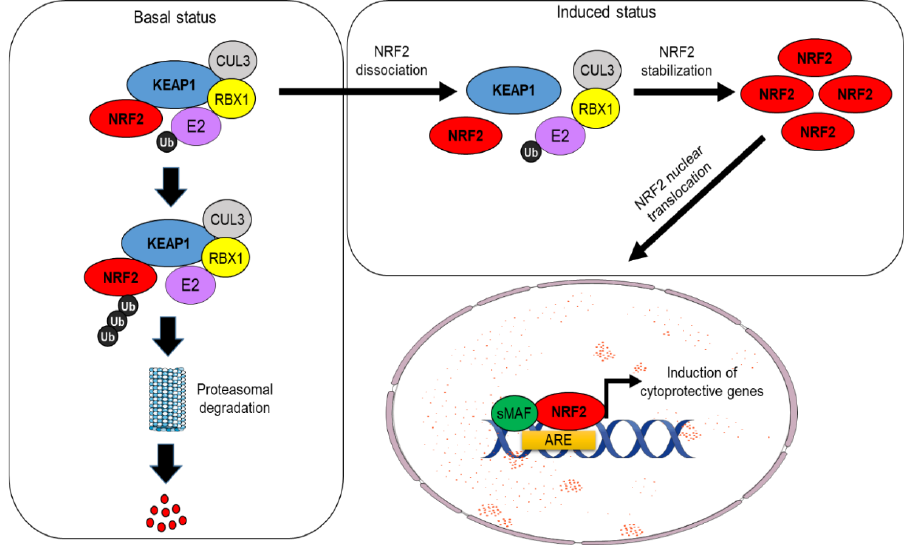
Figure 1. Canonical pathway of KEAP1-dependent NRF2 degradation. Under unstimulated conditions, the interaction between KEAP1 and NRF2 favors its ubiquitination by the CUL3 ubiquitin E3 ligase complex and promotes NRF2 proteasomal degradation in the cytosol. In presence of ROS and other electrophiles, KEAP1 is modified and NRF2 escapes from degradation, enters into the nucleus, and transactivates a large number of cytoprotective genes after heterodimerization with members of the small Maf proteins.